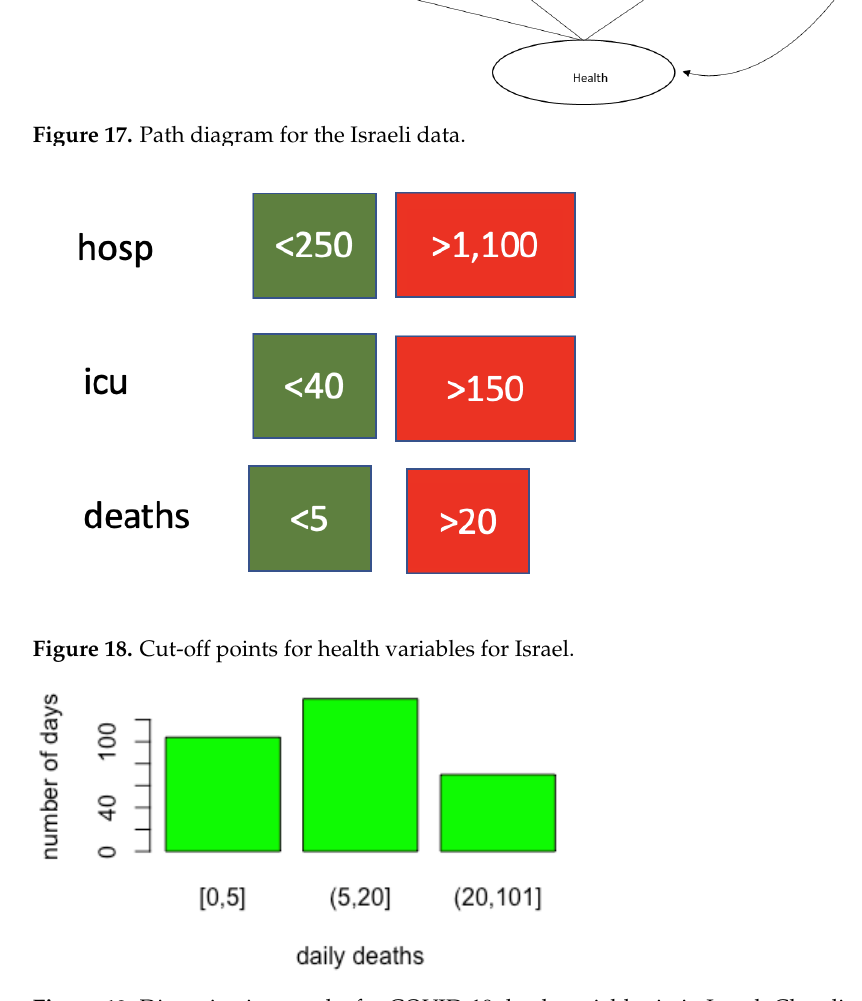
Figure 19. Discretization results for COVID-19 death variables in in Israel. Class limits are reported on the x